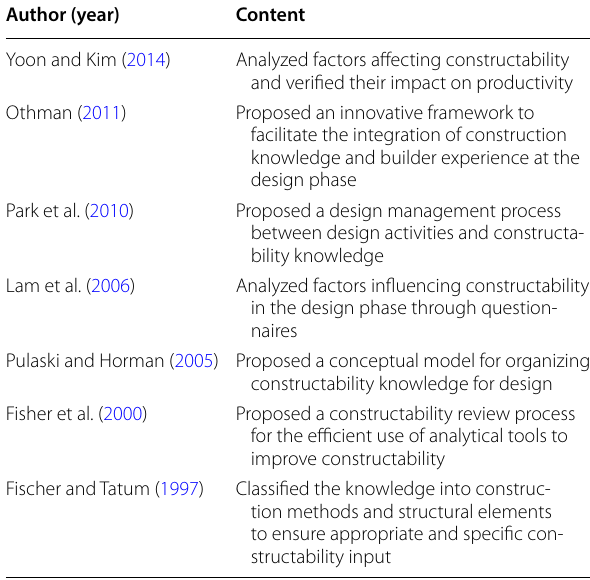
Table 1 Literature review of